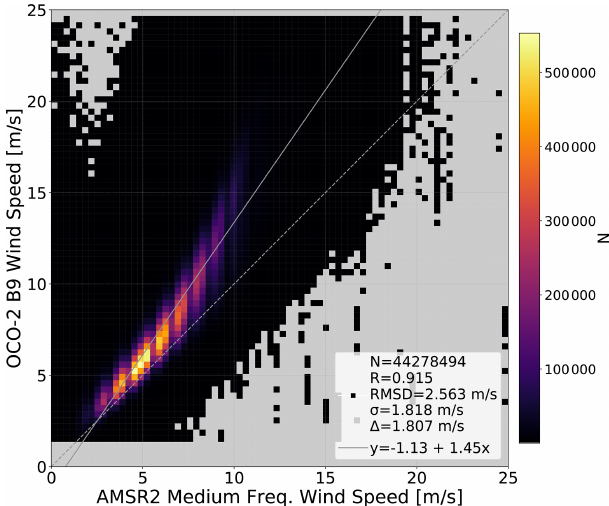
Figure 2. Heatmap of OCO-2 TSIS solar wind speed compared to AMSR2 medium-frequency wind speed. The B9 lite file quality flag and preliminary B10 quality flag have been applied, along with a height scaling. N is the number of retrievals, R is the correlation coefficient, RMSD is the root mean square deviation of the two datasets, σ is the standard deviation between the two datasets, (cid:49) is the mean difference, the dashed line is a one-to-one line, and y is a linear fit plotted as a solid